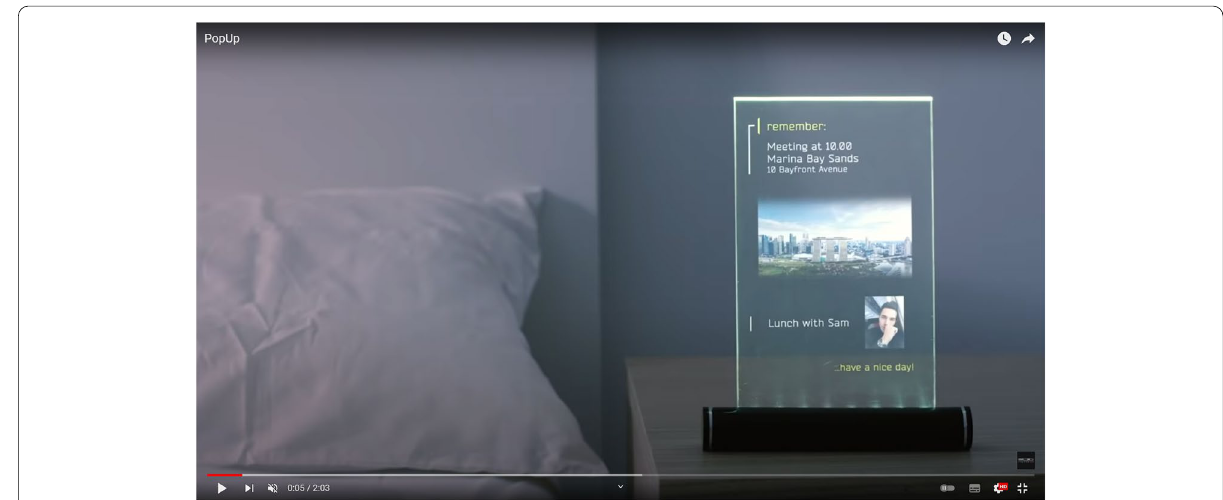
Fig. 1 The story of the Pop.Up begins